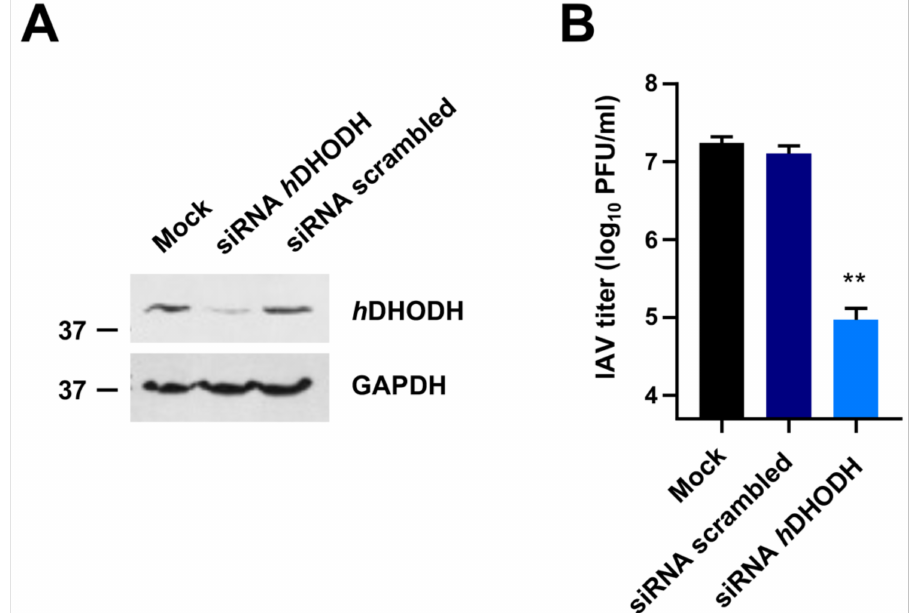
Figure 1. Knockdown of h DHODH affects IAV replication. ( A ) Expression of h DHODH in A549 cells transfected with h DHODH or scrambled negative control siRNAs. At 48 h after of transfection, total protein extracts were prepared, fractionated by 10% SDS-PAGE, and analyzed by immunoblotting with anti- h DHODH mAbs. Immunodetection of GAPDH was used as a control for protein loading. Molecular weight markers are shown beside the left side of each panel. ( B ) VRA was performed in A549 cells mock-transfected or transfected with h DHODH or scrambled siRNAs. At 24 h after transfection, cells were infected with IAV, and after 48 h p.i., the cell supernatants were harvested and titrated by the plaque assay in MDCK cells. The data shown are the means ± SDs of two independent experiments performed in triplicate and analyzed by the unpaired t -test, corrected at FDR q < 0.05. ** ( p < 0.001) compared to the calibrator sample